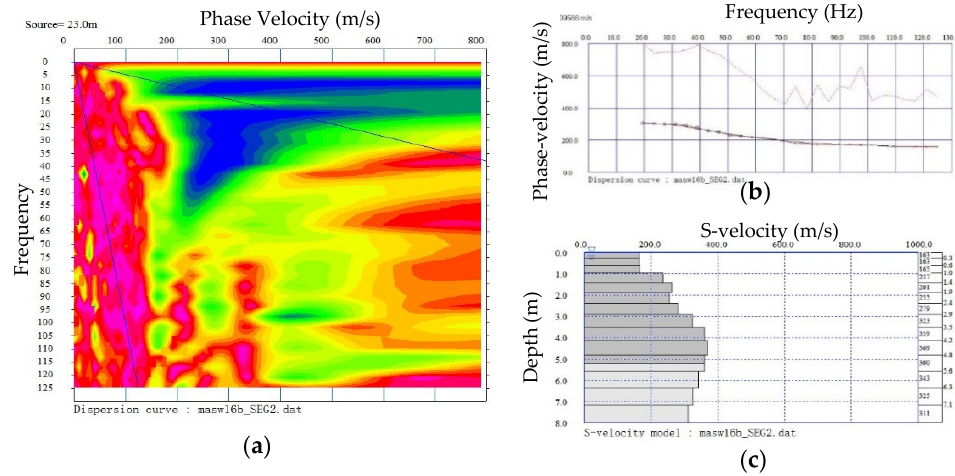
Figure 2. ( a ) Stacked data from Figure 1b shows normalized correlation (red high) and picked f-v (blue line), also synthetic data (black line) from optimum V S model ( b ) Shear velocity profile with ( c ) depth function for α-section.